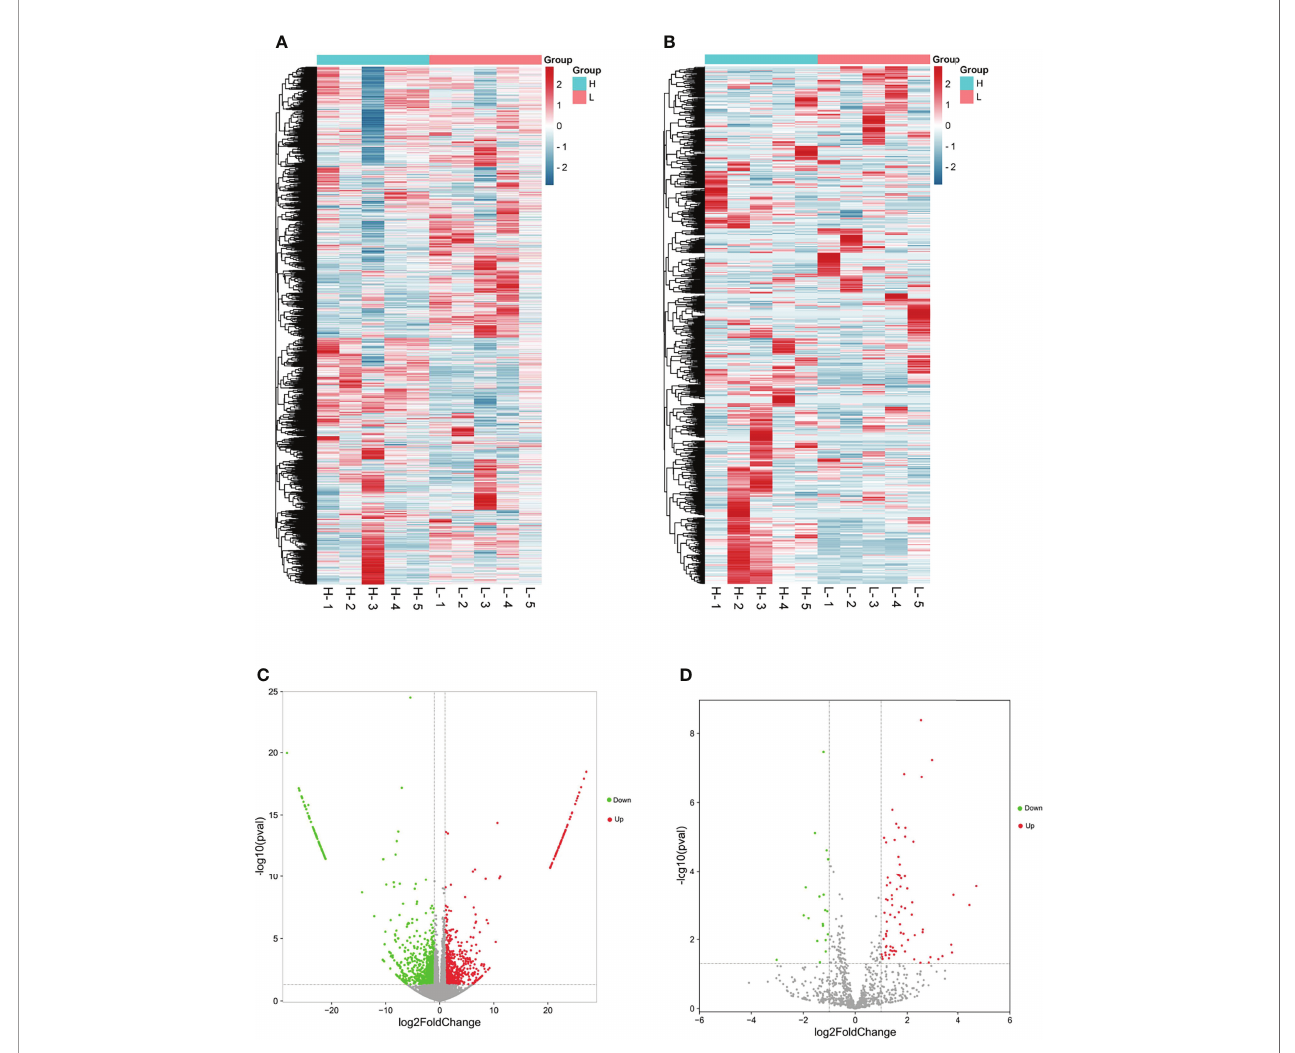
FIGURE 1 | Overall miRNA and mRNA prolife in goat ovary by RNA-seq. (A, C) were the differentially expressed mRNA cluster and Volcano diagram, respectively; (B, D) were the differentially expressed miRNA cluster and Volcano diagram,